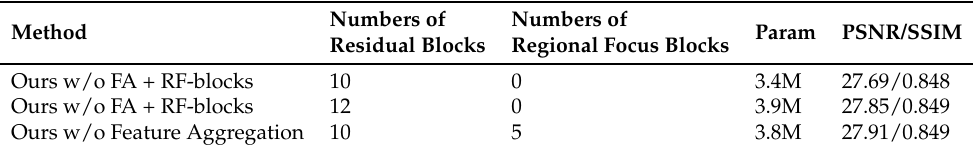
Table 2. The influence of the parameters of the network model on the reconstruction results. The results show that the performance of the network model cannot increase indefinitely with the increase in the number of network model